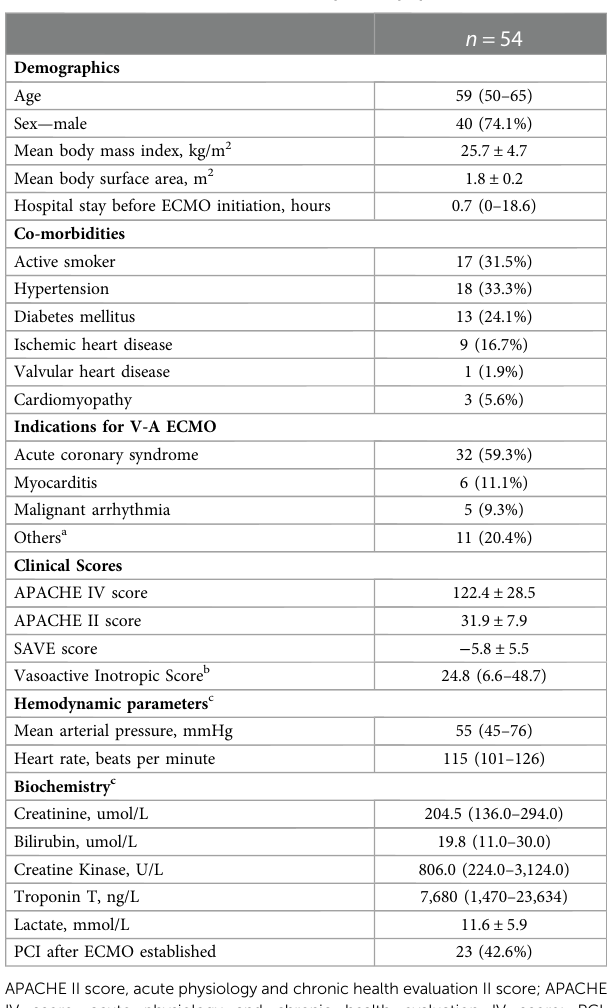
TABLE 1 Baseline characteristics of the patient